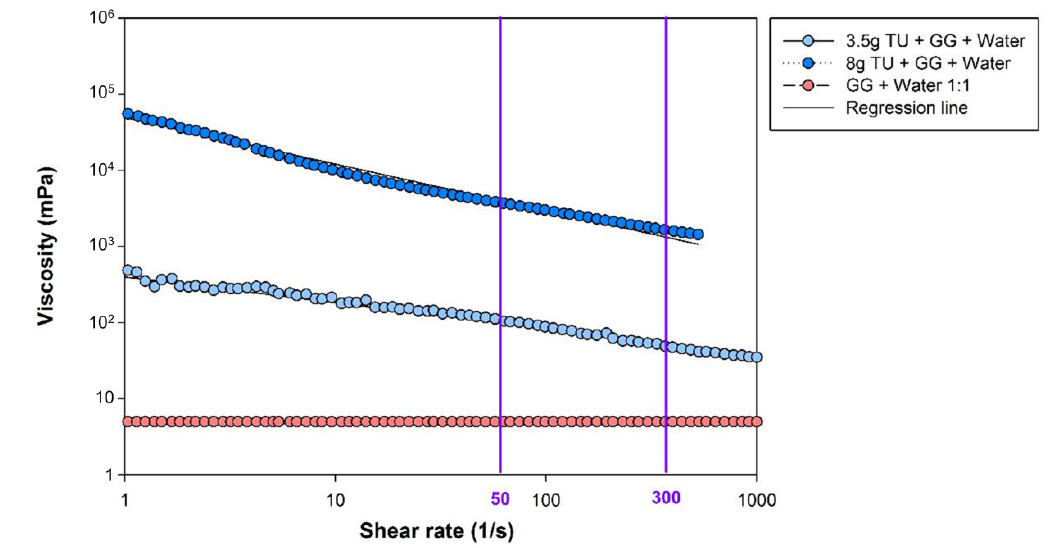
Figure 2. Shear viscosity plots obtained for the shear rate range from 1 s − 1 to 1000 s − 1 . Purple vertical lines represent the main viscosity points along the shear rate values of 50 s − 1 (oral phase) and 300 s − 1 (pharyngeal phase). The orange line reflects the Newtonian behavior of the liquid x-ray contrast mixed with water (1:1 GG and water, < 50 mPa · s at 50 s − 1 ) and the dark and light blue lines shows the Non-Newtonian shear thinning behavior of 120 mPa · and 4000 mPa · s, respectively. Abbreviations: GG, Gastrografin; TU, ThickenUp.